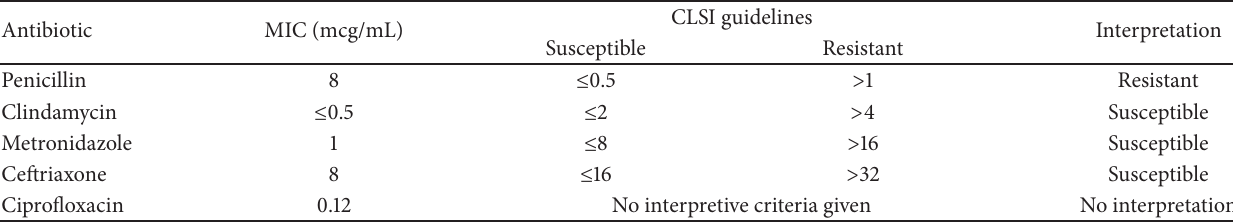
Table 2: Veillonella isolate.